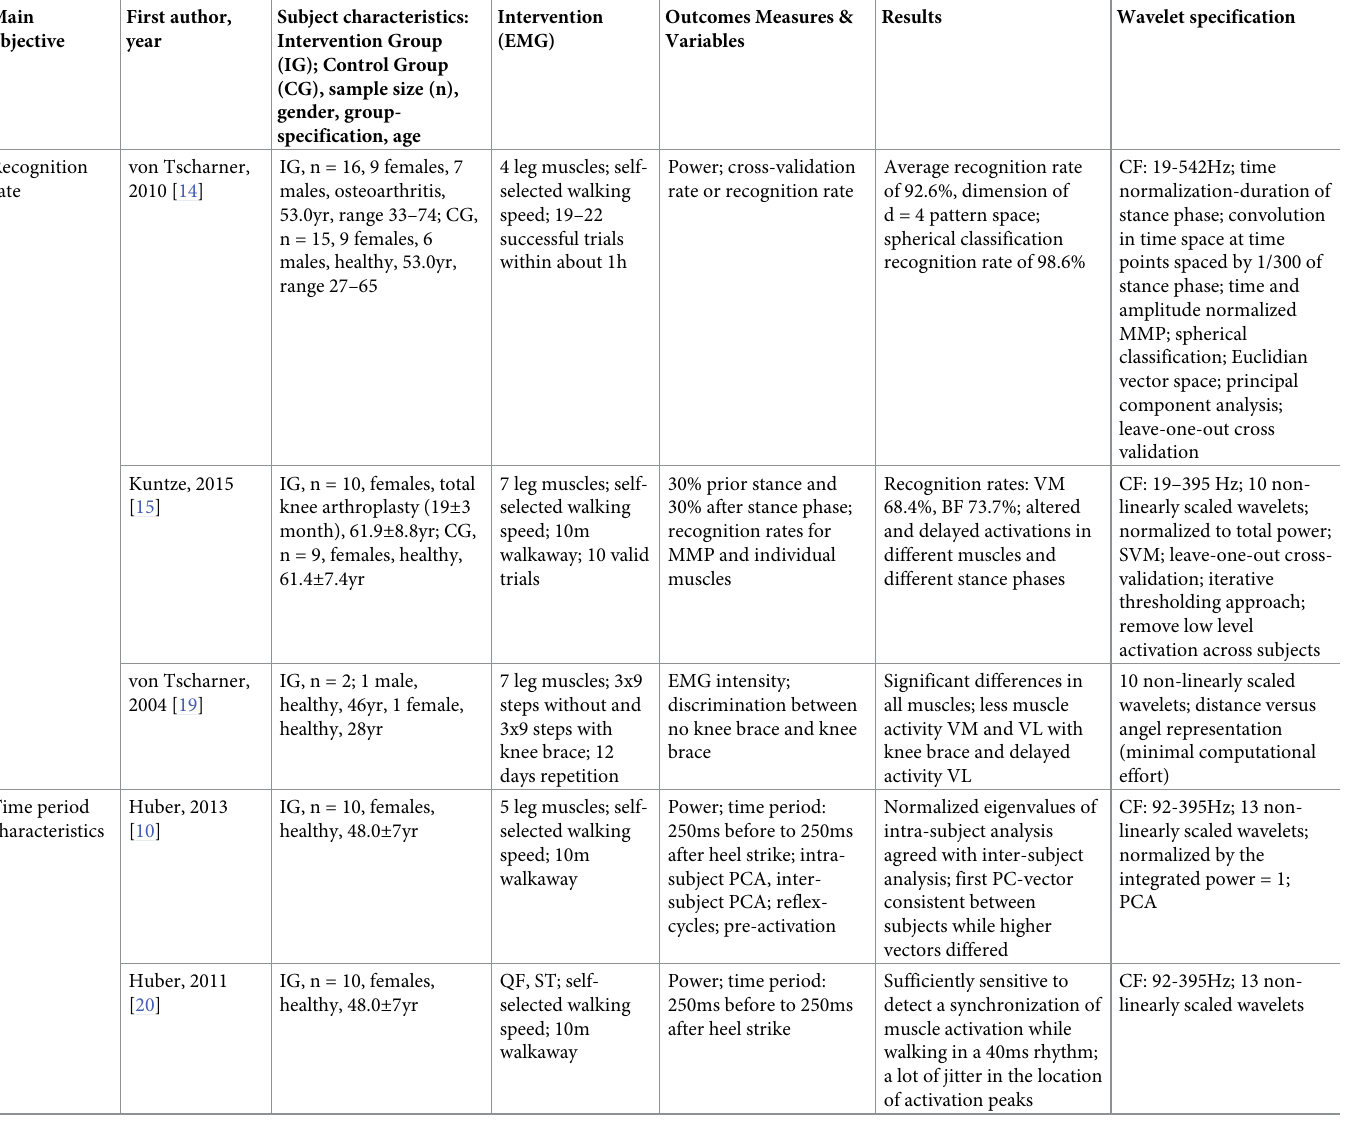
Table 2. Data extraction: Summary of wavelet analysis of EMG of lower extremity muscles while